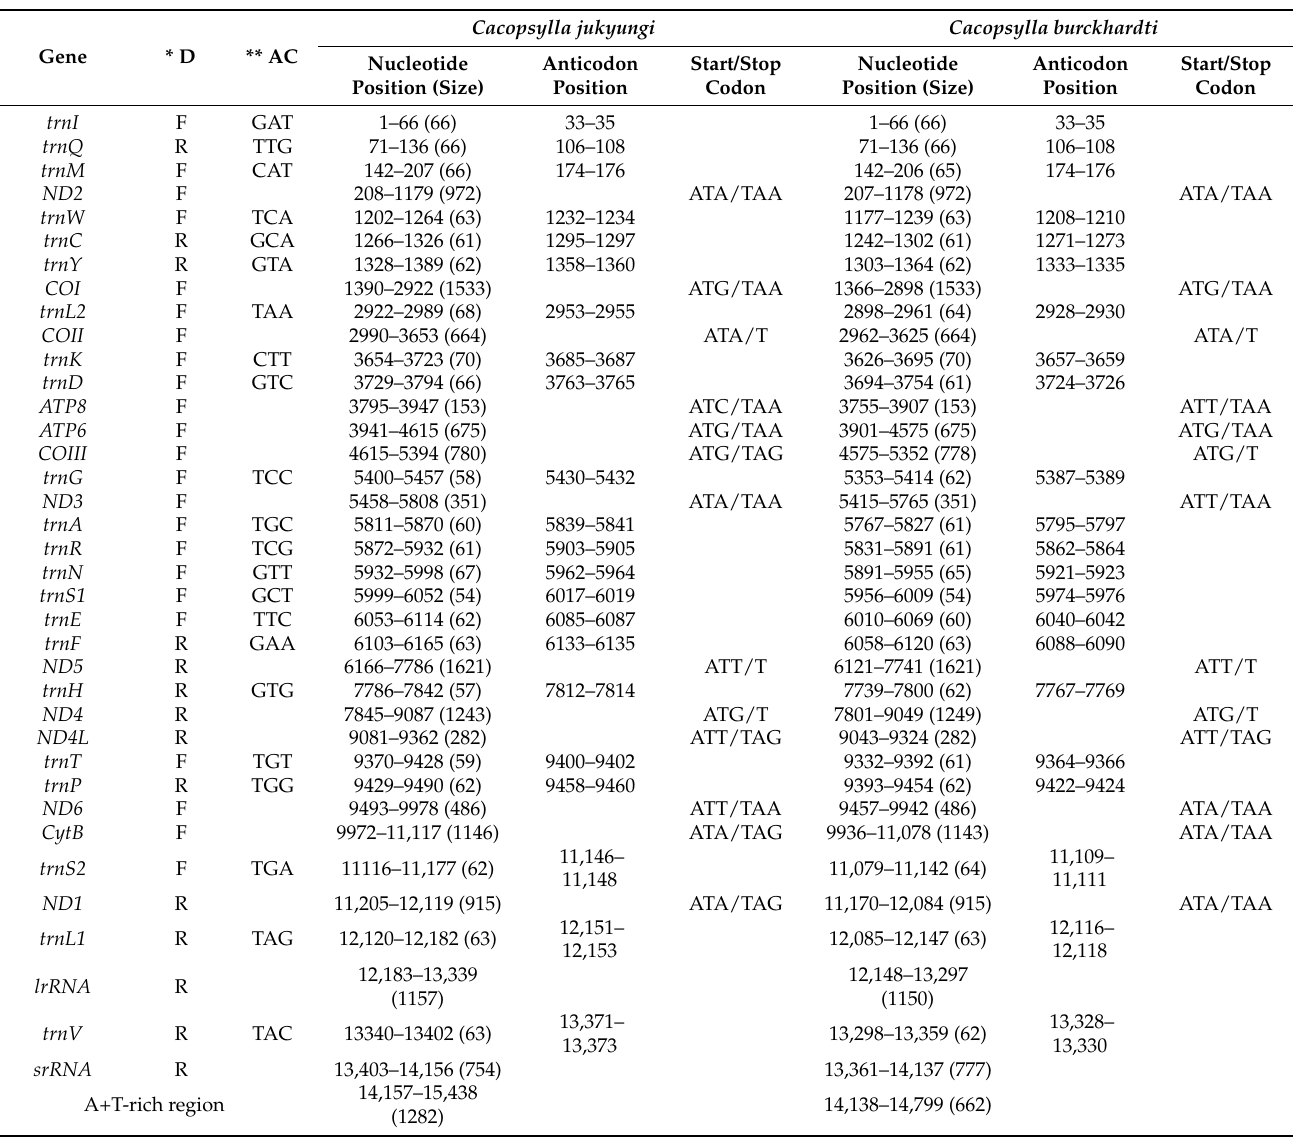
Table 1. Summary of Cacopsylla jukyungi and C. burckhardti mitochondrial